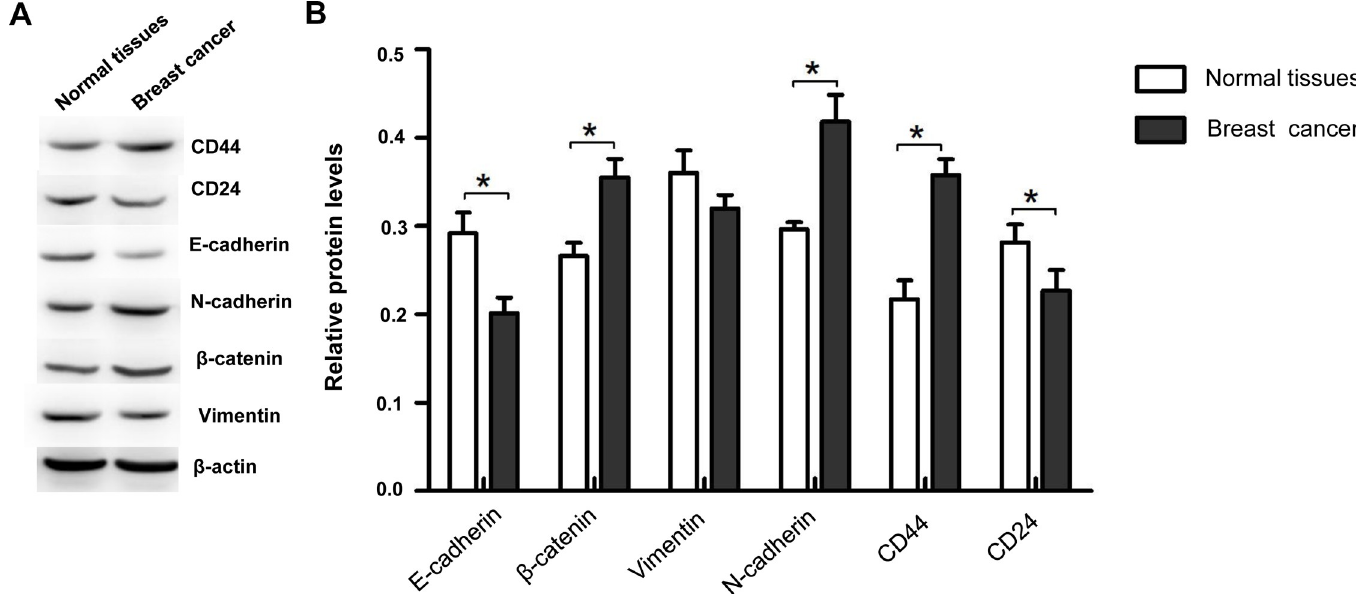
Fig 4. The expression levels of CSCs-related and EMT-related proteins in breast cancer tissues (n = 9). The protein expression levels of CD44, CD24, E-cadherin, N- cadherin, β -catenin, and Vimentin were detected with the Western blot analysis (A). Statistical analysis of the protein expression levels (B). Compared with the normal surrounding tissues, � P <